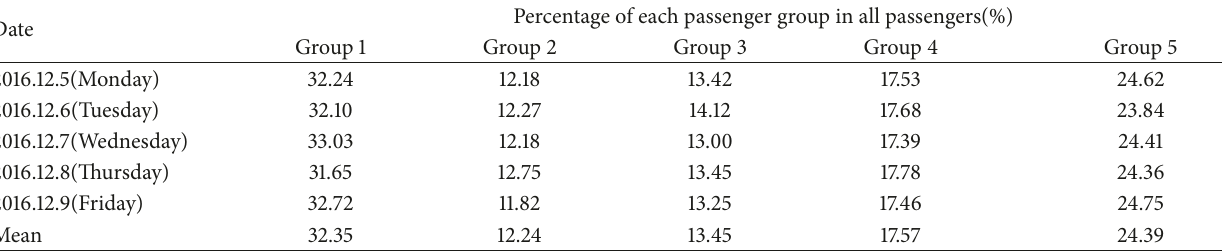
Table 7: Clustering results for different